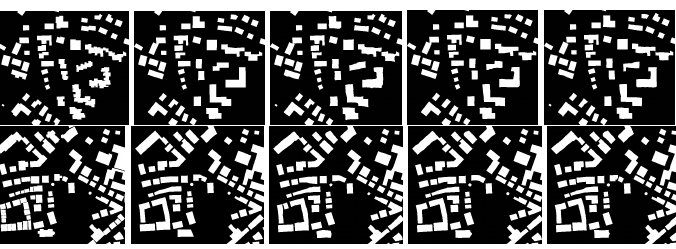
Figure 11. Buildings shown at original scale 1:15,000, from top to bottom: tests 1 and 2; from left to right: input image, target image, U-net prediction, residual U-net prediction, and GAN prediction.